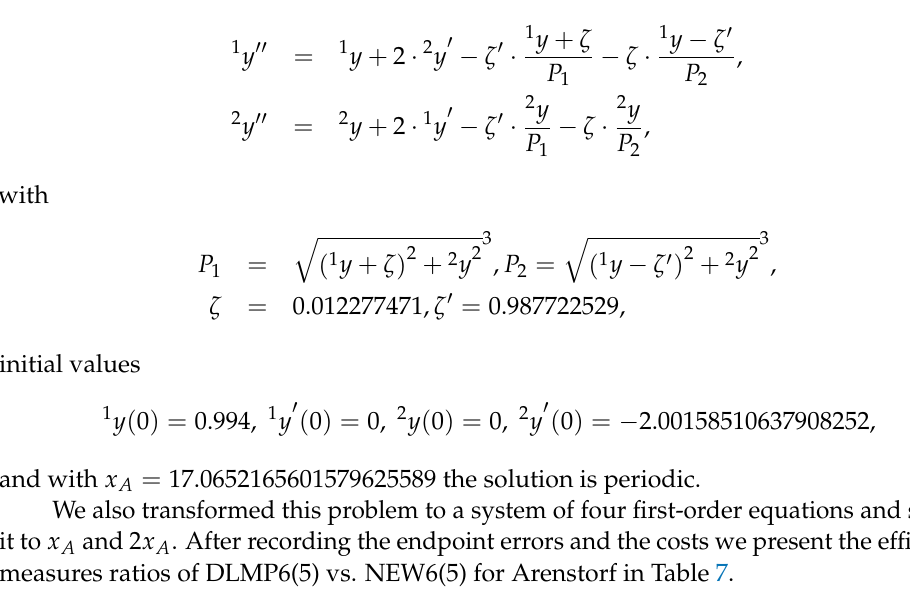
Table 7. Efficiency measure ratios of DLMP6(5) vs. NEW6(5) for